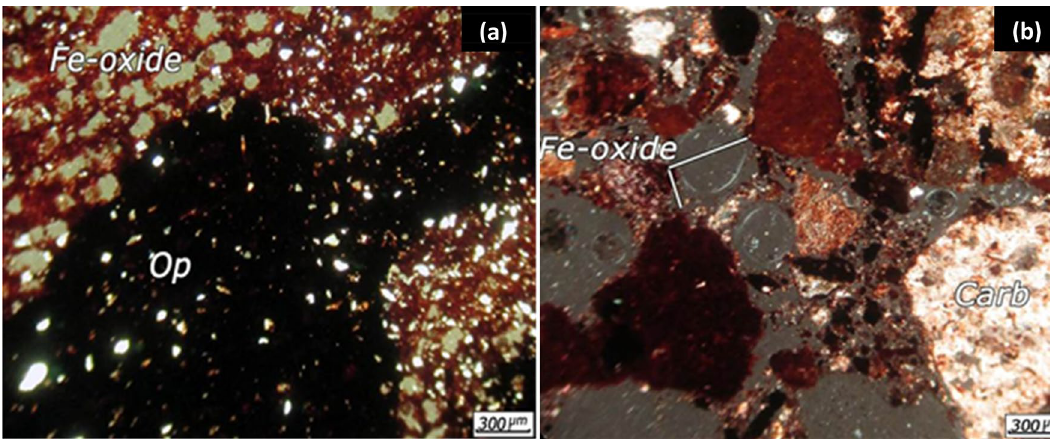
Figure 2. Optical microscopic images from thin section showing ( a ) association of iron minerals with carbonate minerals ( b ) free crystalline phases of iron minerals, ( Op opaque minerals).